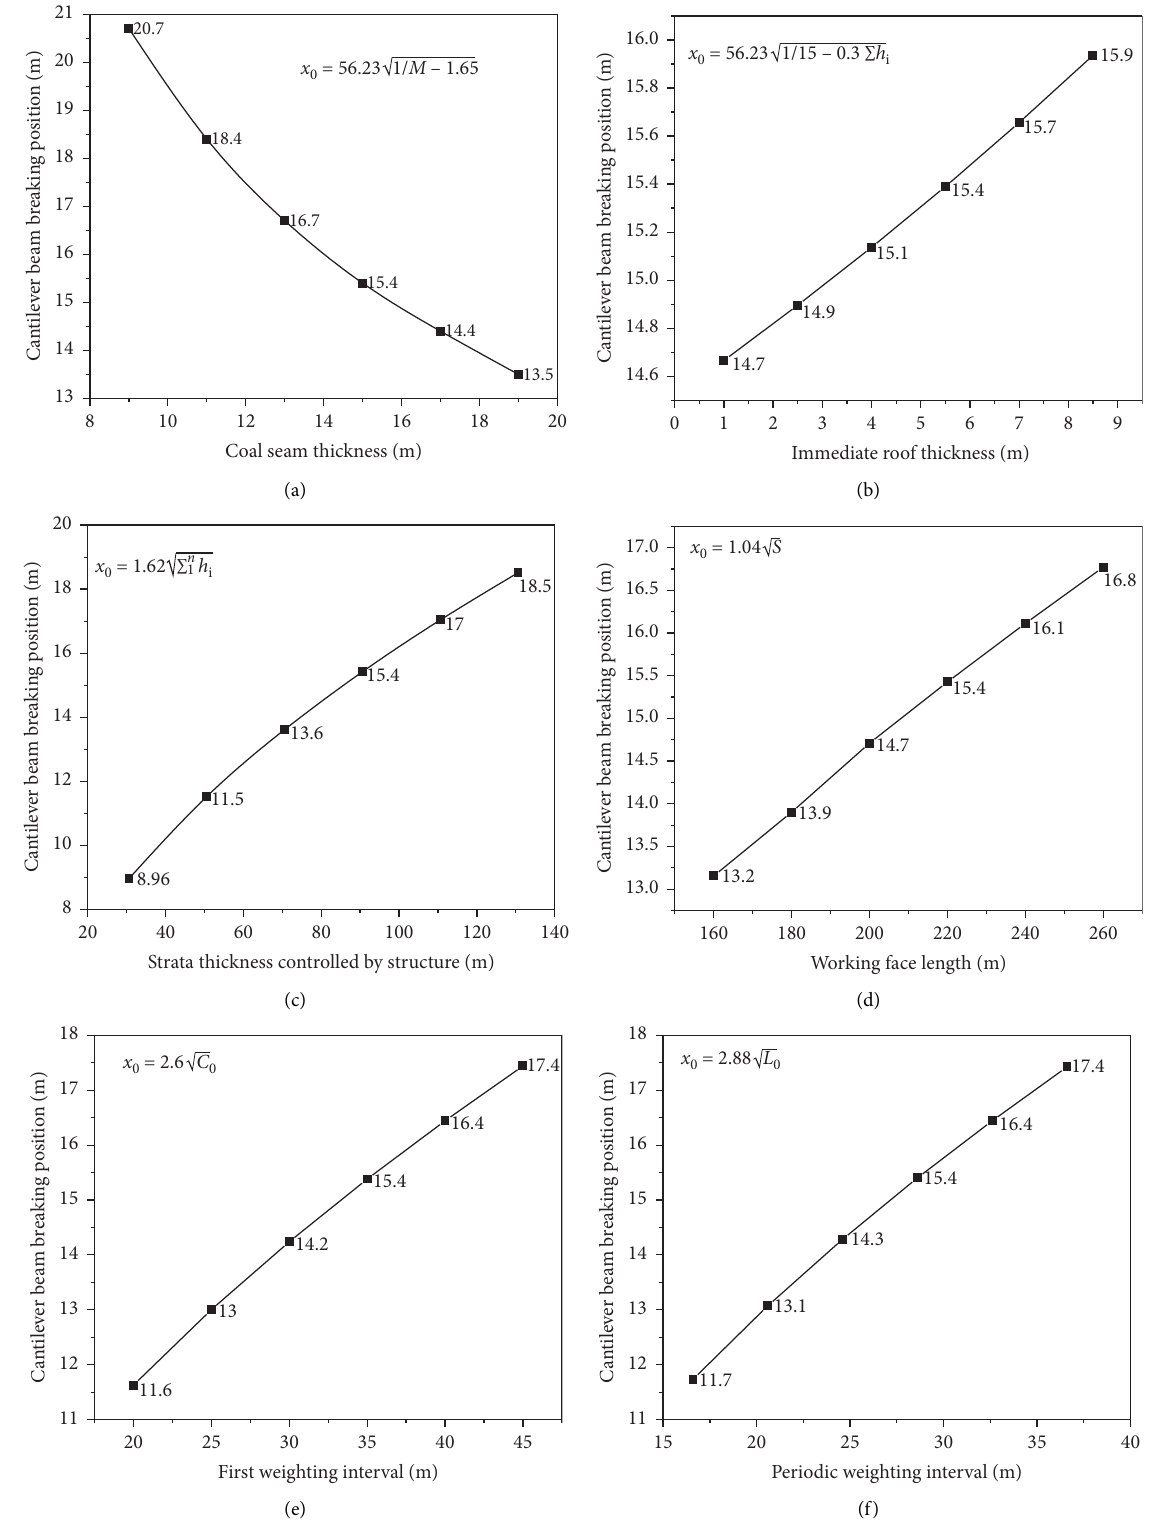
Figure 8: Influence factors of cantilever beam breaking position. (a) Coal seam thickness. (b) Immediate roof thickness. (c) Strata thickness controlled by structure. (d) Working face length. (e) First weighting interval. (f) Periodic weighting